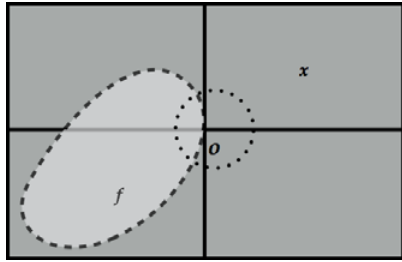
Figure 14: The visual argument to demonstrate that a neighboring tile to tile relation meet (in tile x ) must be